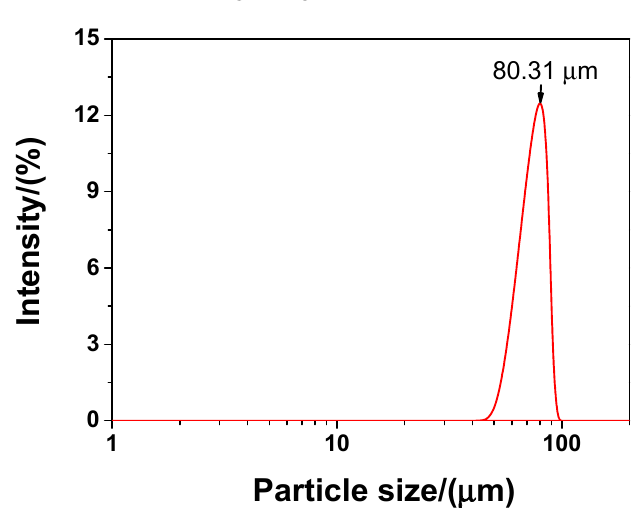
Figure 2. The grading curve of the silica sand.